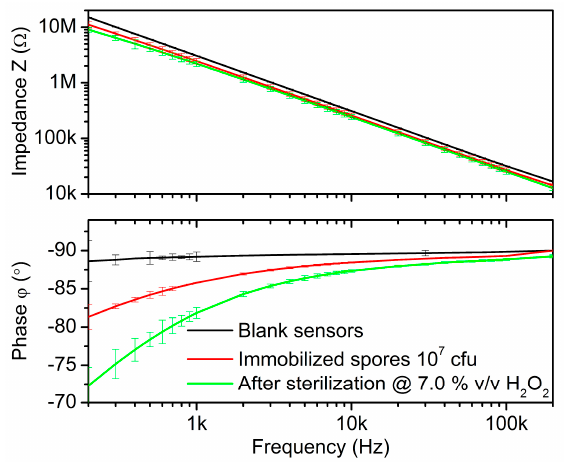
Figure 2. Averaged Bode plot of four independent sensors. Characterizations in vacuum: blank sensor structure (black lines), after immobilization of B. atrophaeus -spores (10 7 cfu/IDE) (red lines) and after sterilization with H 2 O 2 vapor for 0.3 s at c(H 2 O 2 ): 7.0% v / v , T gas : 240 °C, V air : 10 m 3 /h (green lines).